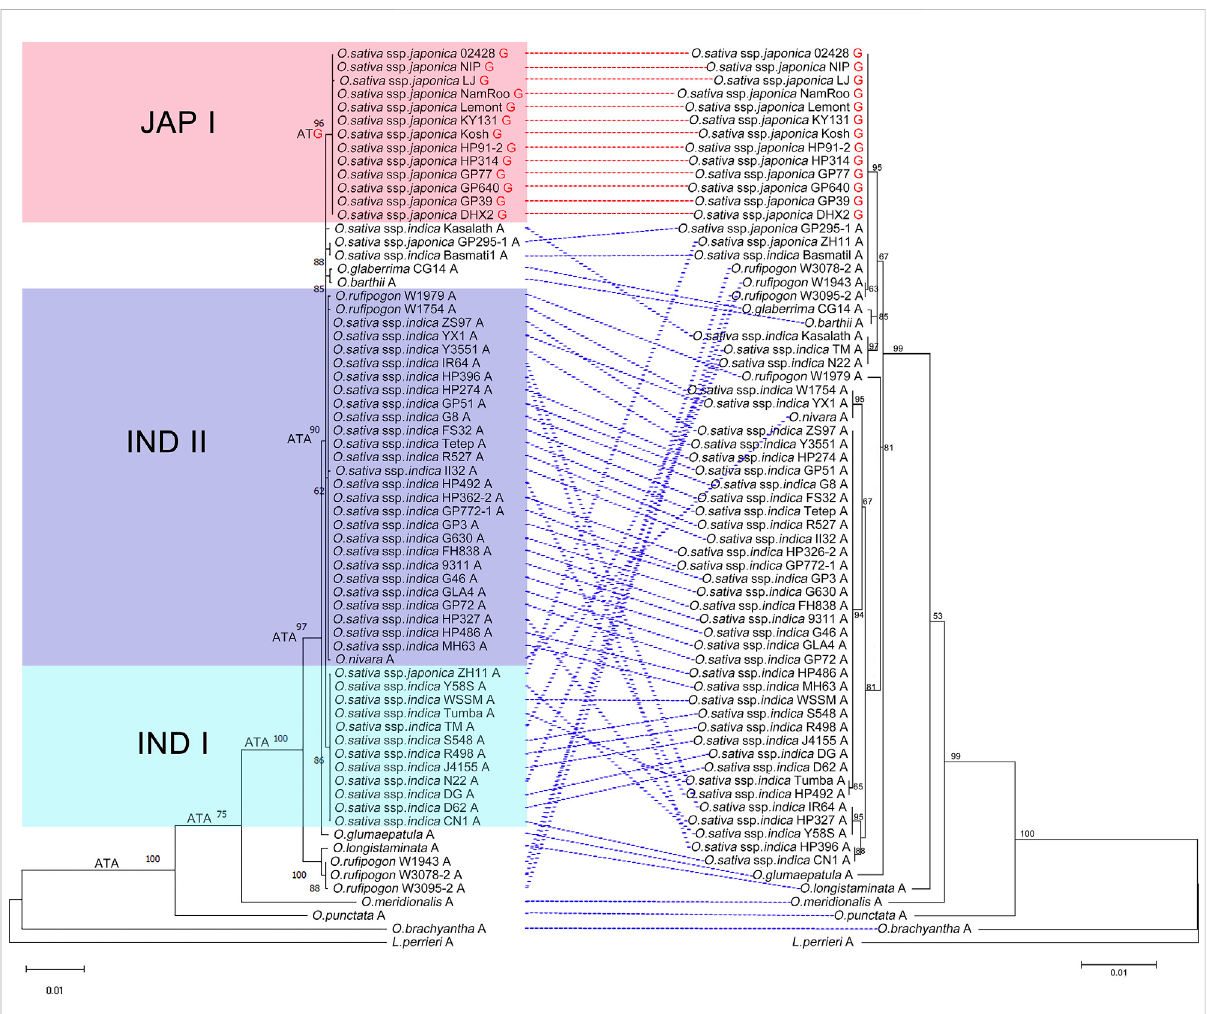
FIGURE 3 Reconstruction of the evolutionary history of Pi-d2 (left) and OSPUB15 (right) in Oryza with Leersia perreri as outgroup. The tree shows a set of inferrednucleotides(states)atthePi-d2polymorphicposition1383.Non-synonymouschangesatthecodonaredepictedinblack(ATA)orred(ATG) next to their corresponding node. Nucleotides (guanine in red and adenine in black) at position 1383 of Pi-d2 in different accessions are indicated at the end of the name. Pi-d2 and OSPUB15 identi fi ed in the same accessions are connected by dotted lines (the assumed susceptible alleles are dotted in red, while the assumed resistant alleles are dotted in